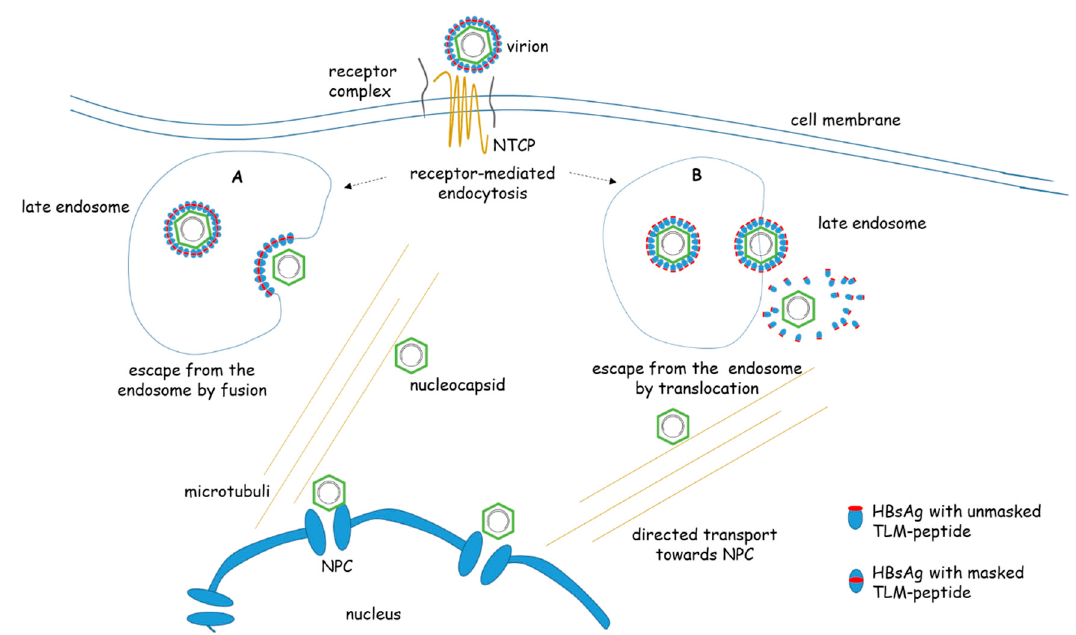
Figure 3. Entry and post-entry steps of HBV. HBV enters the cell by binding to a receptor/receptor- complex containing NTCP (Sodium taurocholate cotransporting polypeptide). The internalization occurs by receptor-mediated endocytosis. This cartoon shows two models that describe the escape from the late endosome: A) by membrane fusion leading to the release of the nucleocapsid into the cytoplasm. B) By a translocation process mediated by the TLM peptide. In the mature virus the TLM (red dot) is masked. Due to proteolytic processing of the surface protein in the endosomal compartment the TLM is unmasked and exposed to the surface of the viral particle. The surface-exposed TLM peptides mediate the translocation across the endosomal membrane into the cytoplasm. Here the processed surface proteins are stripped off. The cytoplasmic nucleocapsid is delivered by a directed transport involving microtubule to the nuclear pore complex (NPC). (NTCP = Sodium taurocholate cotransporting polypeptide, TLM = translocation motive)